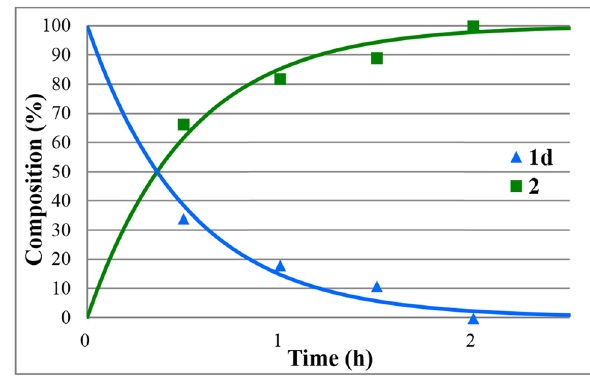
Figure 8: Concentration pro fi le for the components ( 1d and 2 ) during the hydrolysis of isopropyl diphenylphosphinate ( 1d ) under MW conditions at 160°C. The R 2 measure of goodness of fi t is 0.896.